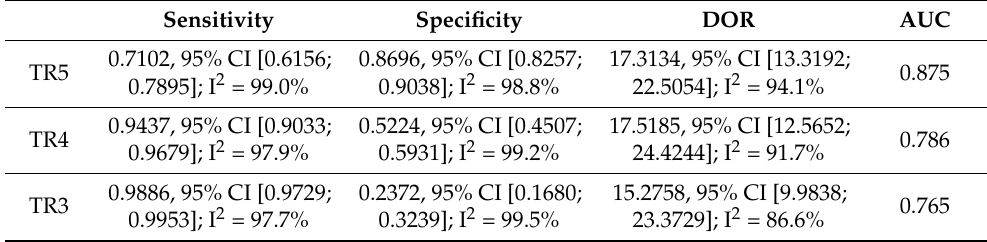
Table 2. Diagnostic efficacy and the ROC curves of ACR TI-RADS